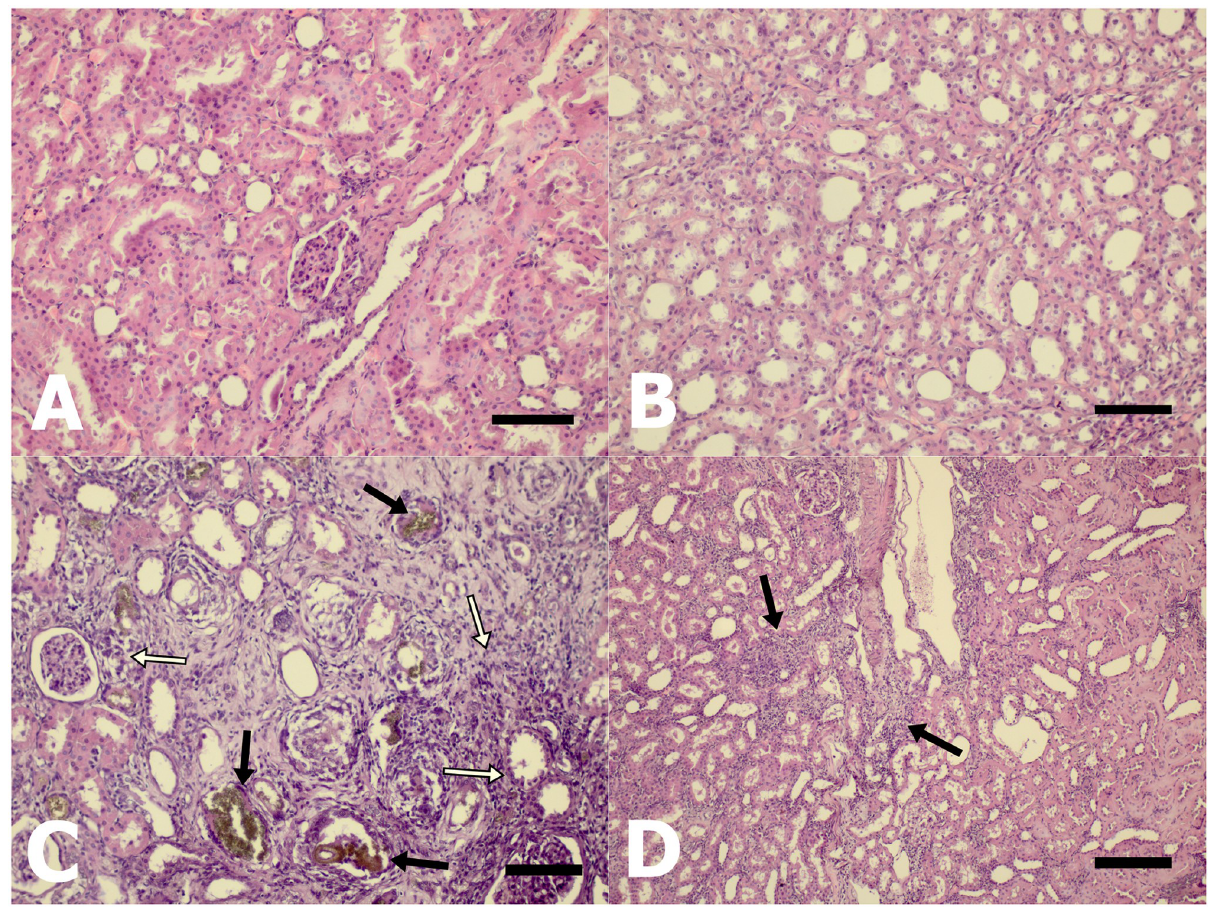
Fig 1. Histological kidney sections stained with H&E from (A) CTL, (B) CTL-Pre, (C) CKD, and (D) CKD-Pre. Scale bars: (A, B, C, D); 220 μ m.